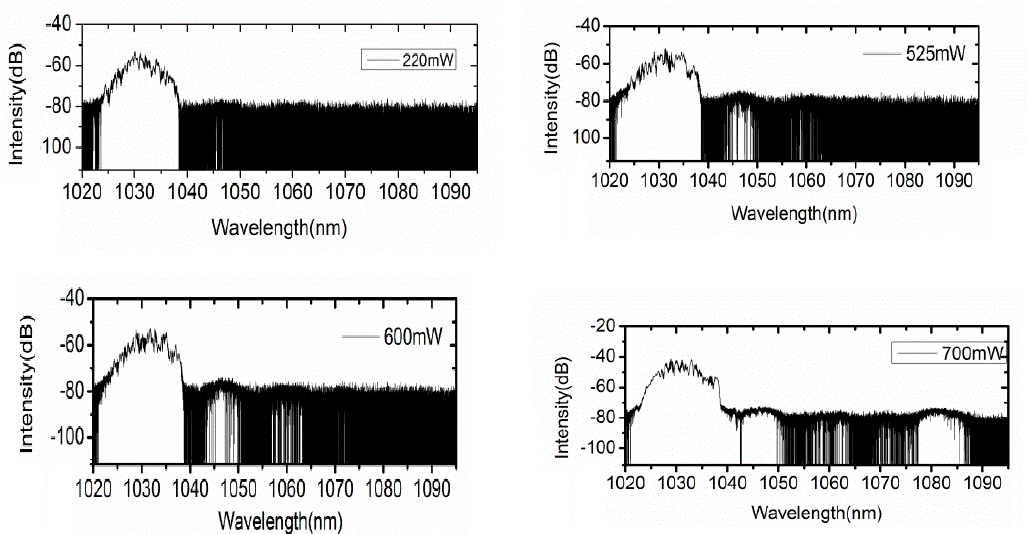
Figure 2. The nonlinear effect of stimulated Raman scattering (SRS) in the fiber preamplifier.